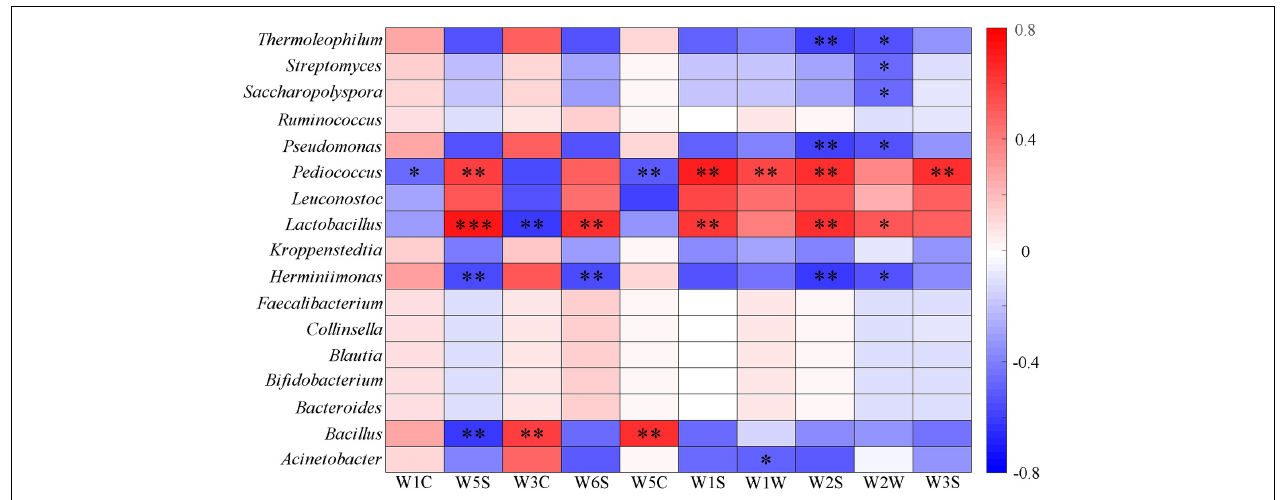
FIGURE 9 | Heatmap of correlation between flavor and major bacterial genera of fermented grains ( ∗ 0.01 < P < 0.05, ∗∗ 0.001 < P < 0.01, ∗∗∗ P <